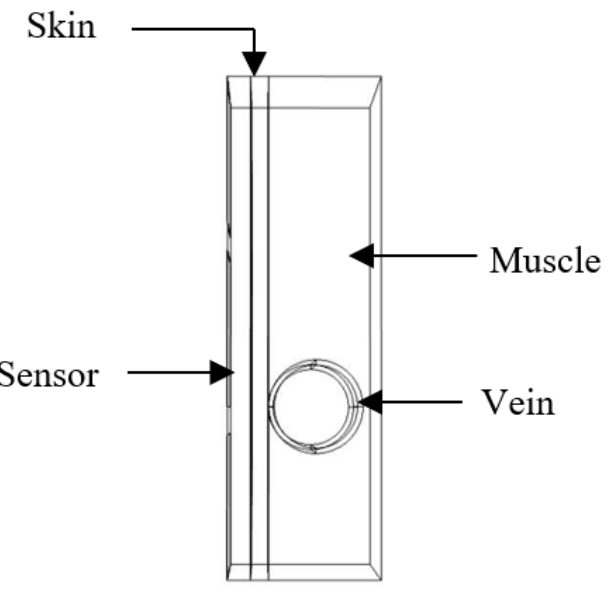
Figure 2. Part of the biological phantom on